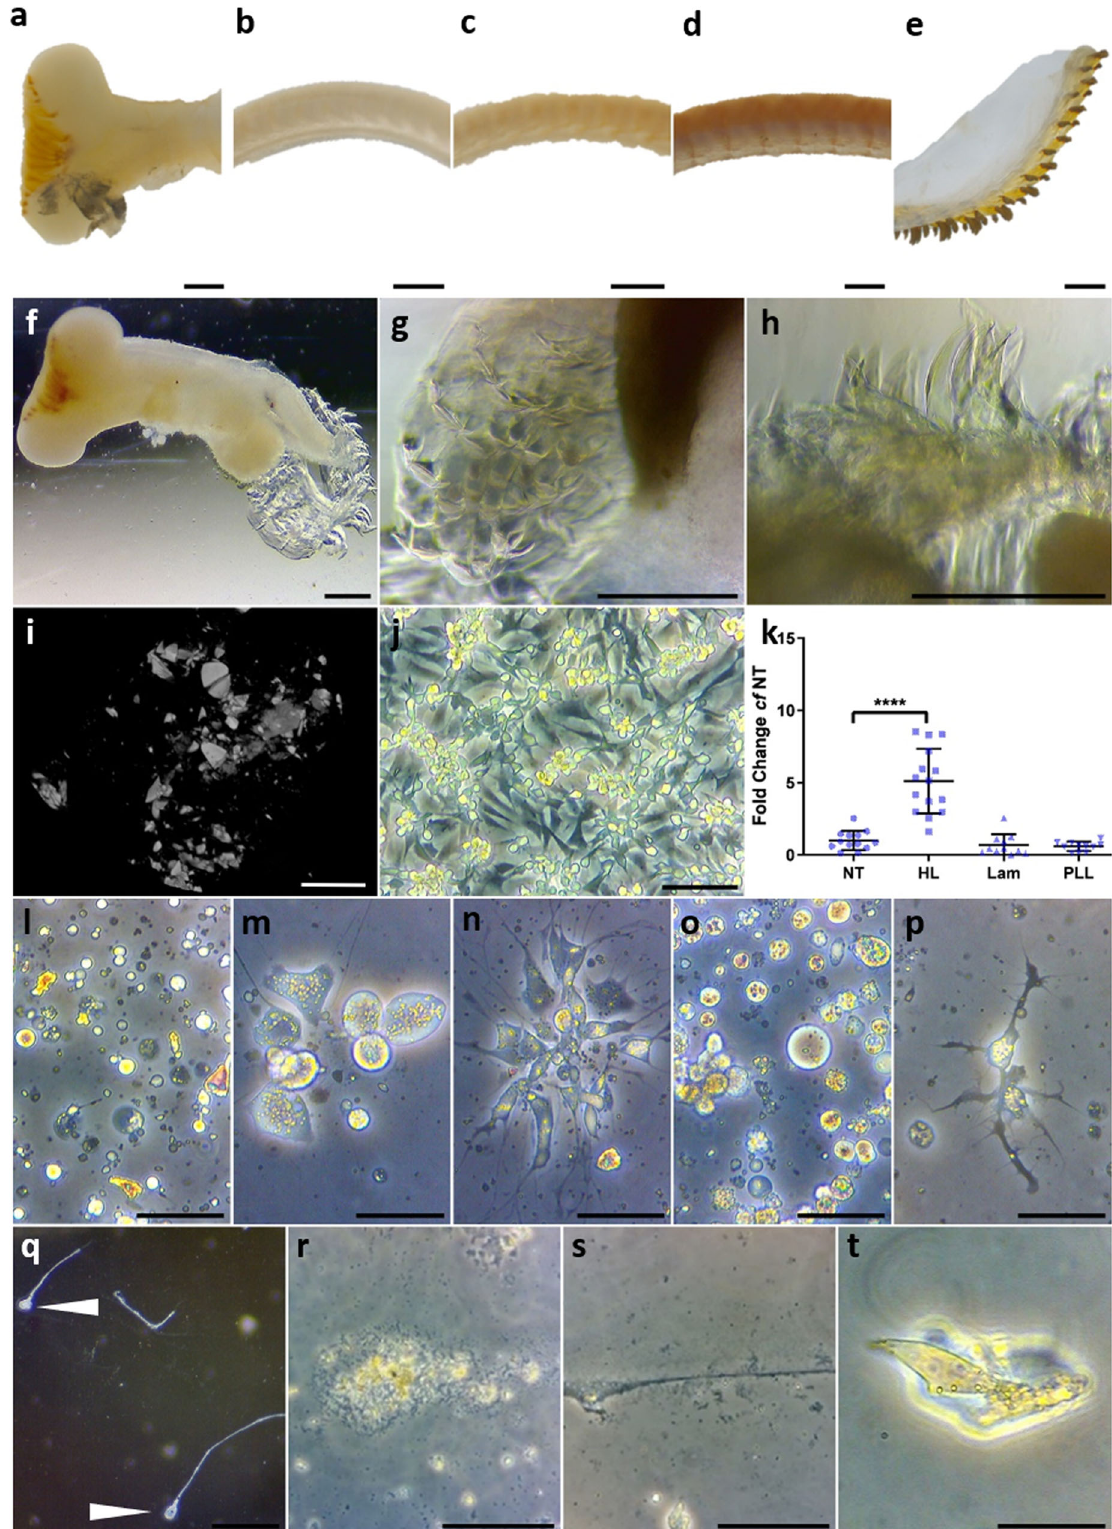
signi fi cantly up- or downregulated in the FZ and radula sections compared to the foot muscle (Supplementary Data 2 and 3). Comparison between genes differentially expressed at each radula stage identi fi ed clear overlap of genes common across the radula (1,078 downregulated and 301 upregulated), but also genes speci fi cally expressed in one speci fi c stage only, with the